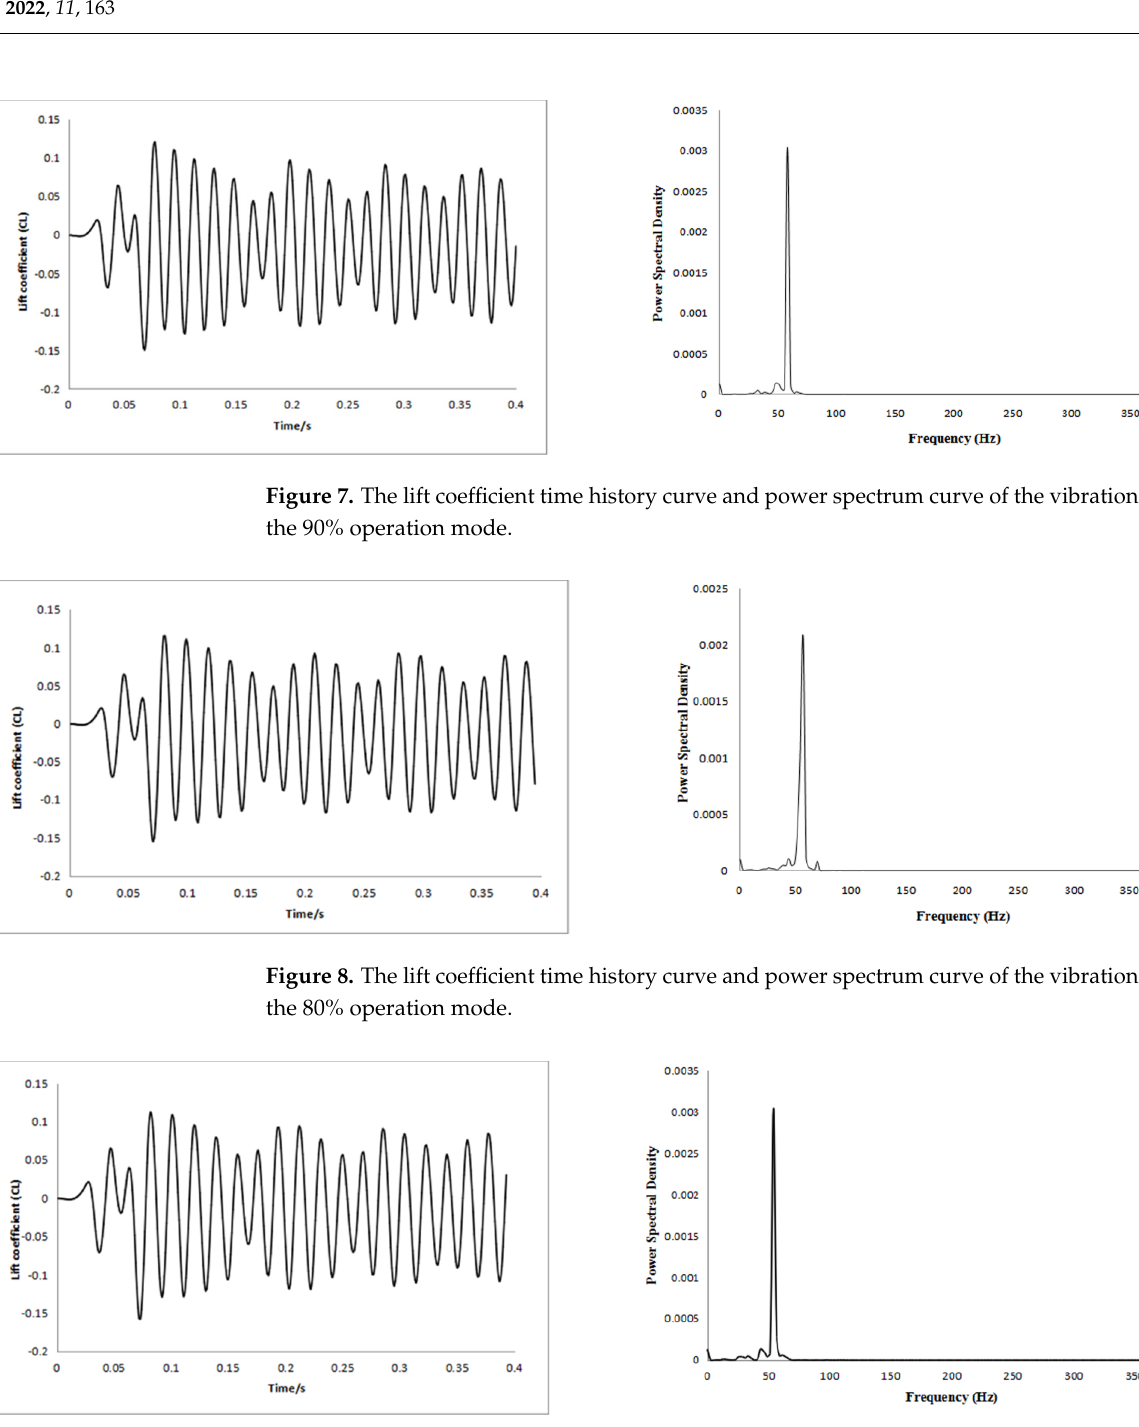
Figure 9. The lift coefficient time history curve and power spectrum curve of the vibration area under the 70% operation mode.